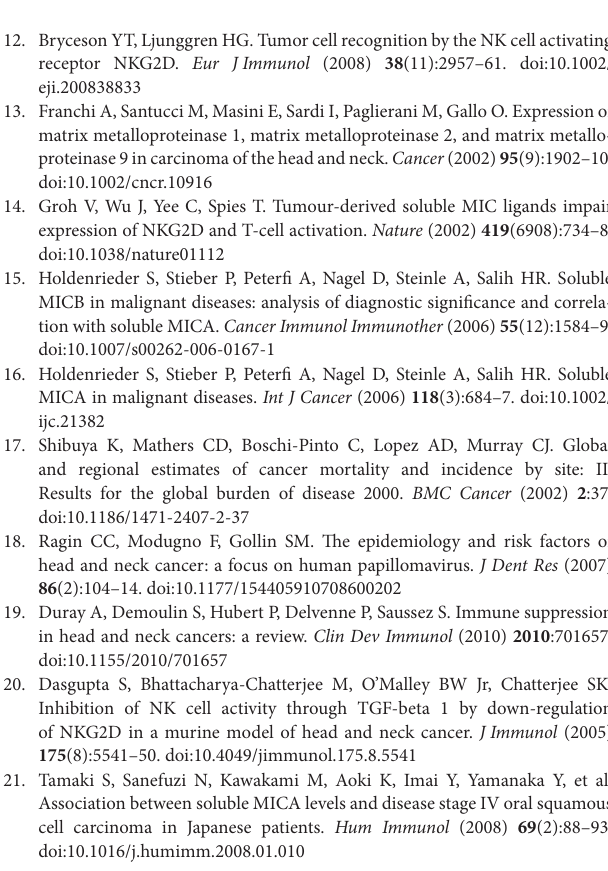
against associated tumor spheroids via reduced migratory capability and a decreased